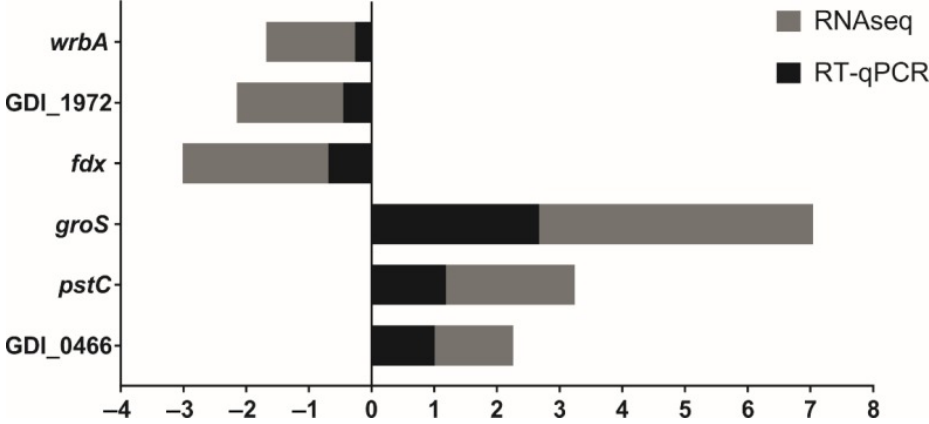
Figure 4. Expression pattern comparing RNA-seq and RT-qPCR analysis.